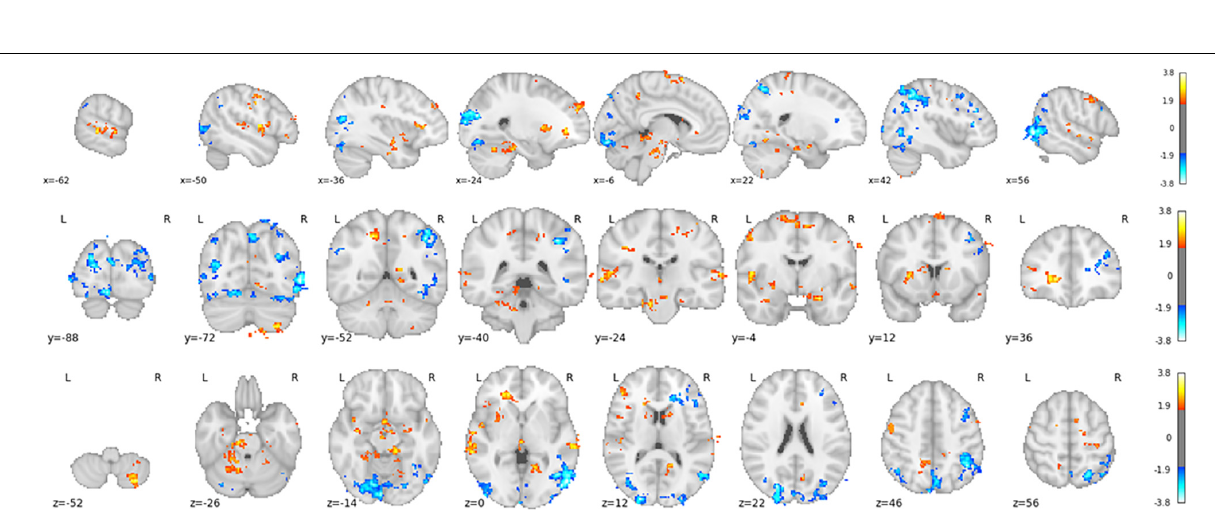
Frontiers in Human Neuroscience |